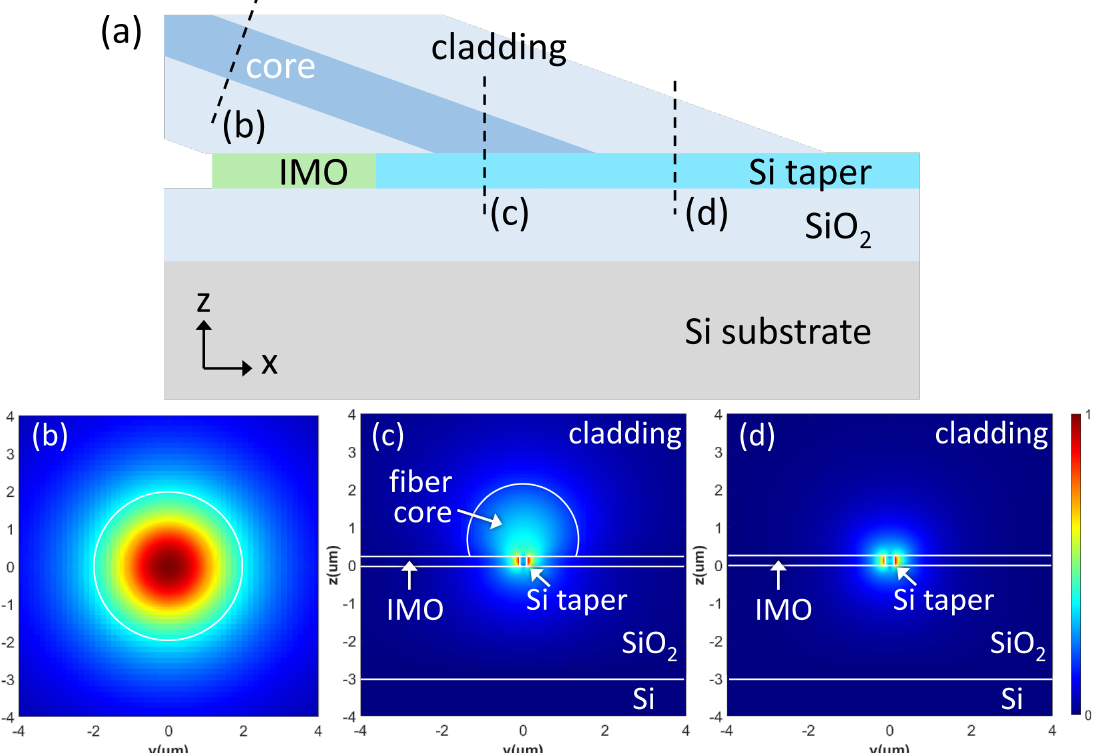
Figure 2. Numerical calculation results showing the field distribution profiles and mode evolution between the optical fiber and silicon waveguide. ( a ) Side view of the proposed structure. The proportion of the structure is exaggerated for a clear illustration. ( b ) The fundamental fiber mode of y-polarization. ( c ) The intermediate profile over both the fiber core and silicon taper region. ( d ) The mode field entirely converted into the TE-like fundamental mode of Si strip